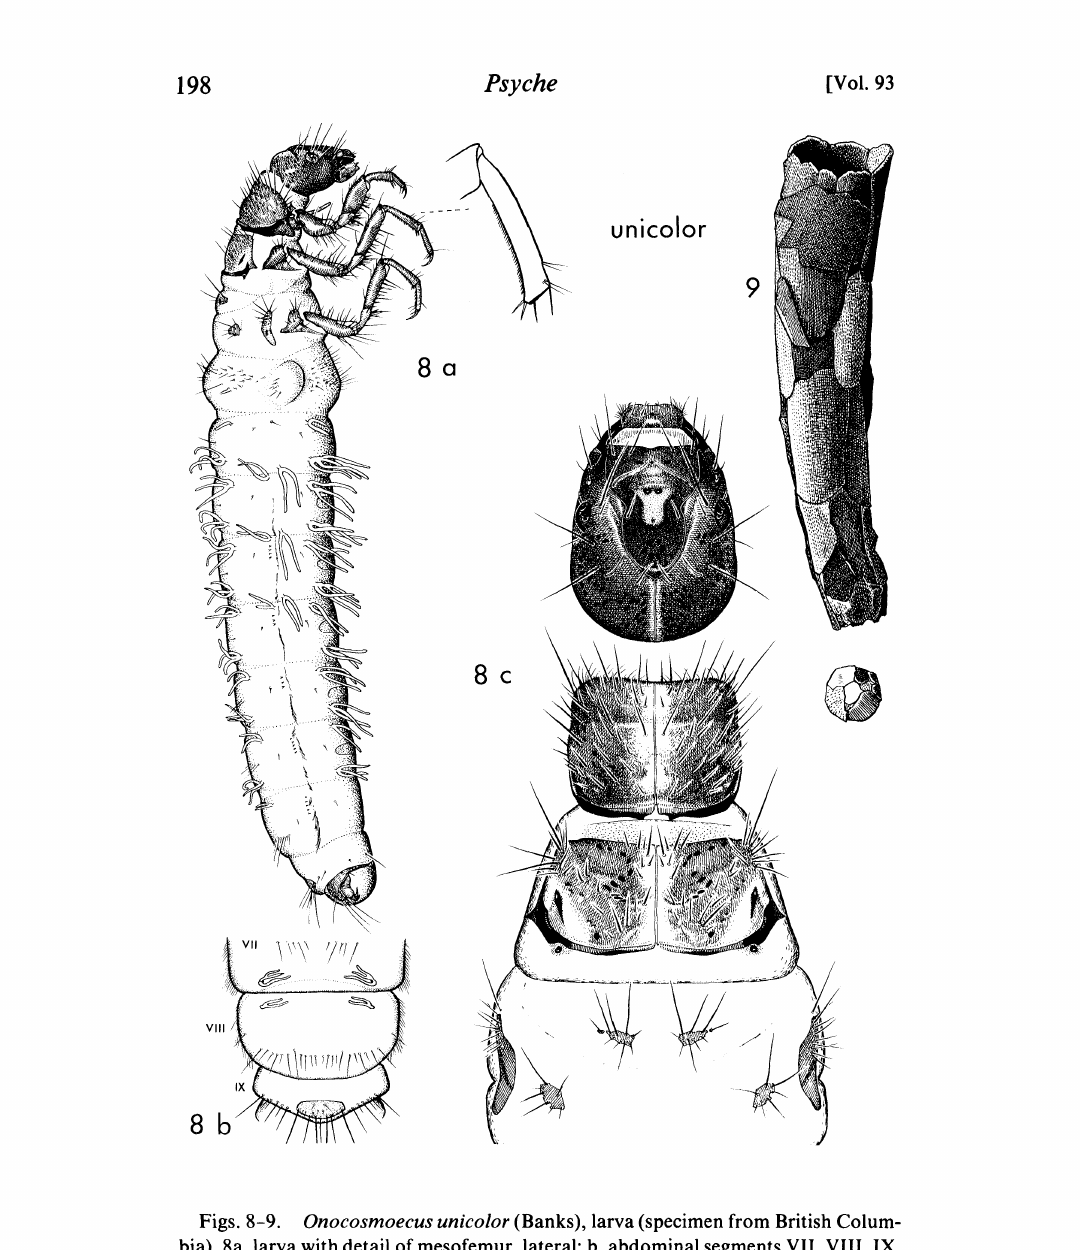
Figs. 8-9. Onocosmoecus unicolor (Banks), larva (specimen from British Colum- bia). 8a, larva with detail of mesofemur, lateral; b, abdominal segments VII, VIII, IX, dorsal; c, head and thorax, dorsal. 9, case, detail of posterior